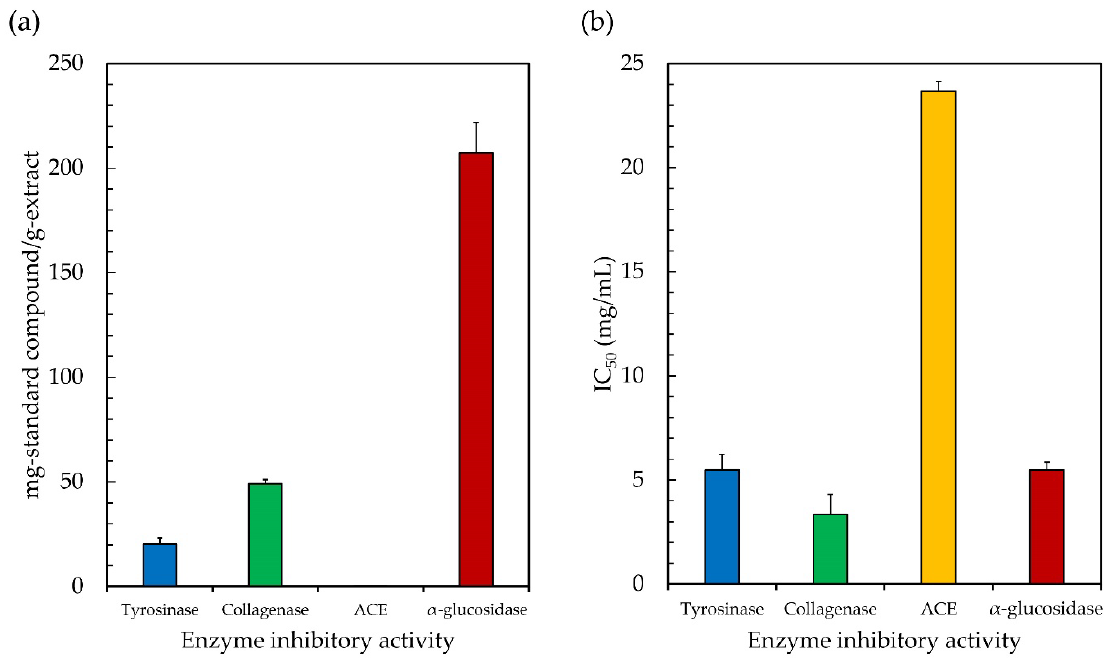
Figure 3. The half maximal inhibitory concentration (IC 50 ) ( a ) and the equivalent standard com- pound capacity ( b ) of the ethanolic extract from cyanobacteria, Leptolyngbya sp. KC45 on enzyme inhibitory activity.